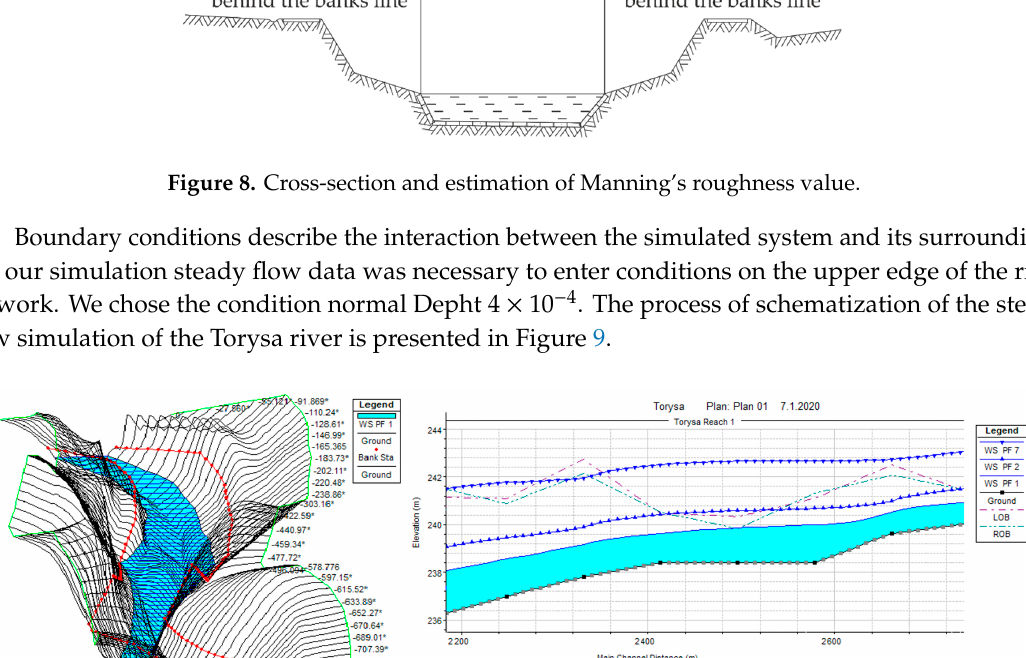
Figure 8. Cross ‐ section and estimation of Manning’s roughness value.